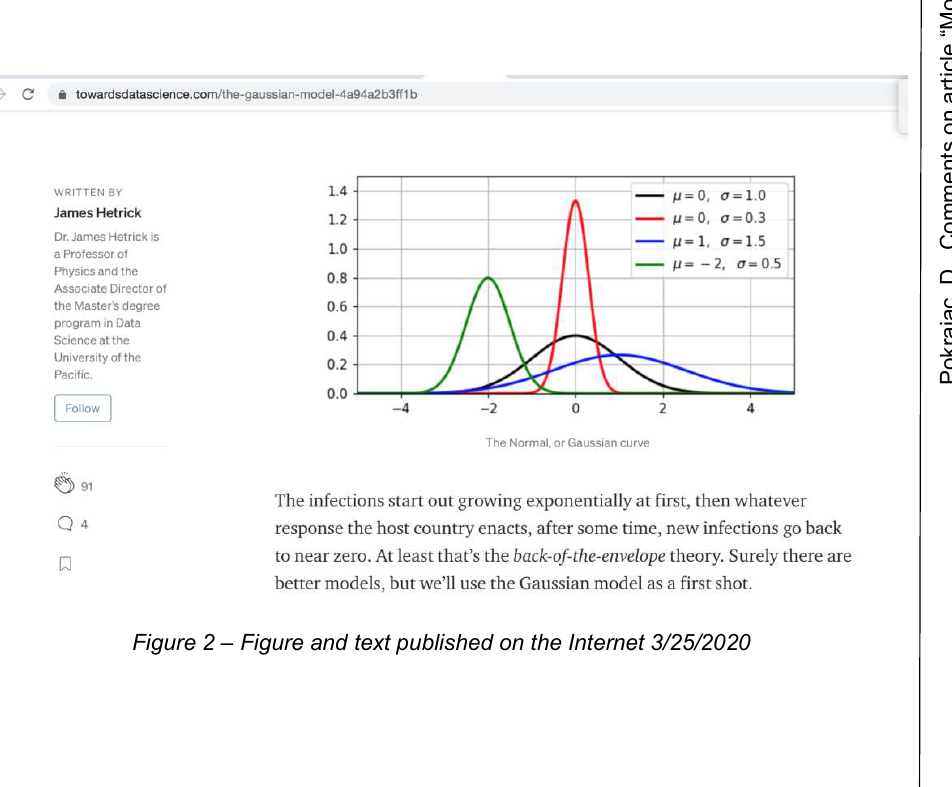
Figure and text published on the Internet